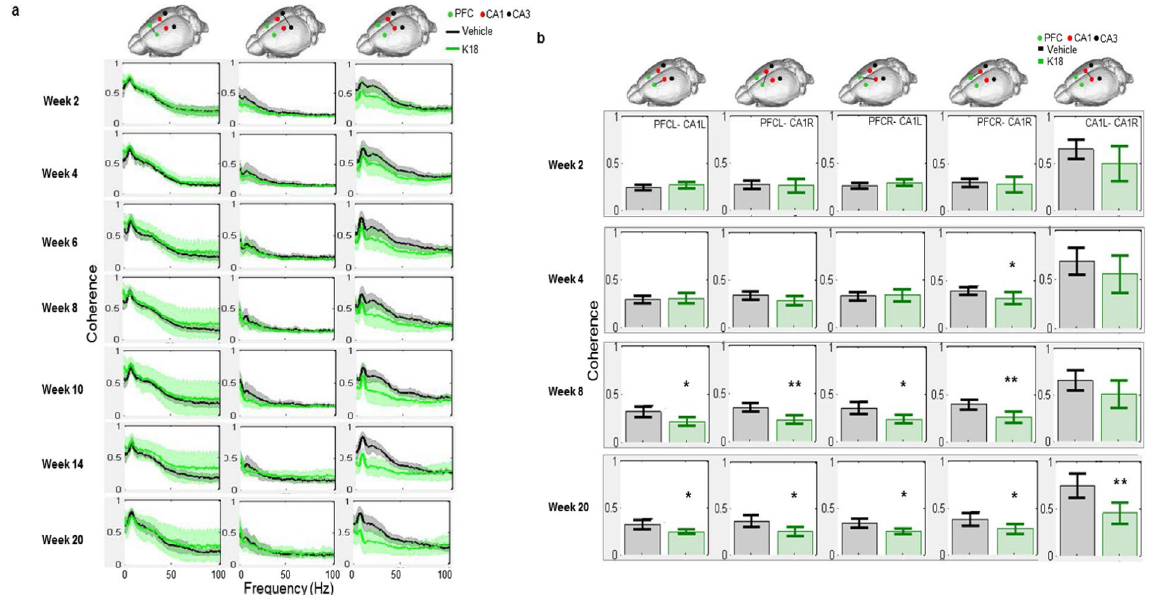
coherent activity ( ± 95 CI) in the theta frequency range. ( b) mean coherent activity in the theta frequency range over weeks 2, 4, 8 and 20. Data are presented as mean values ± SEM for buffer (black, n = 9) and K18 (green, n = 8) groups. 3 animals across different conditions were discarded from the analysis because of signal